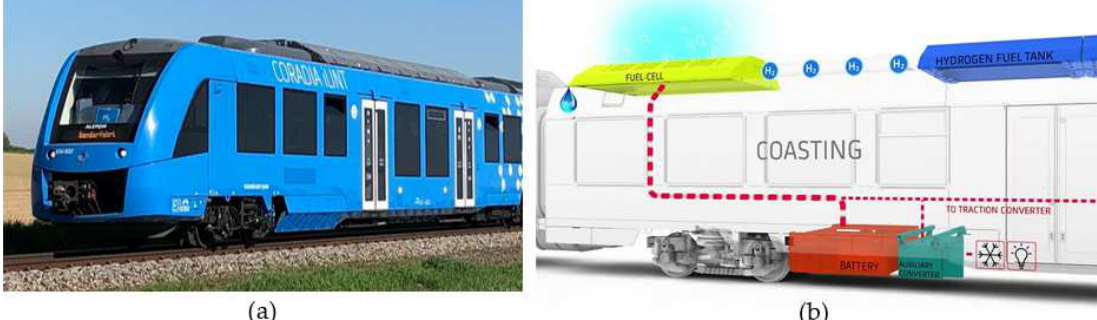
Figure 2. ( a ) Coradia iLint, the world’s first hydrogen fuel cell passenger train [66]. Reproduced with permission from Alstom/R.Frampe; ( b ) Layout of FC train elements onboard [67].